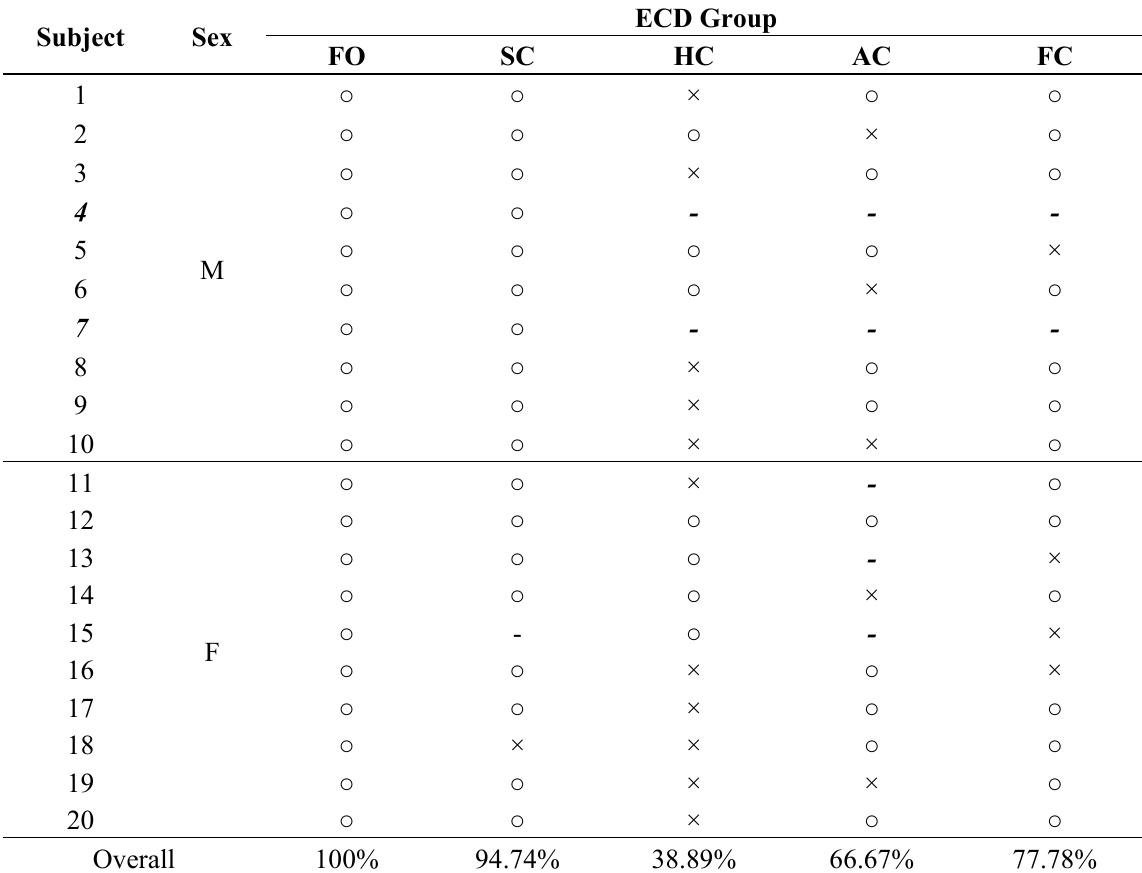
Table 7. Results of Estimation accuracy for each ECD group.